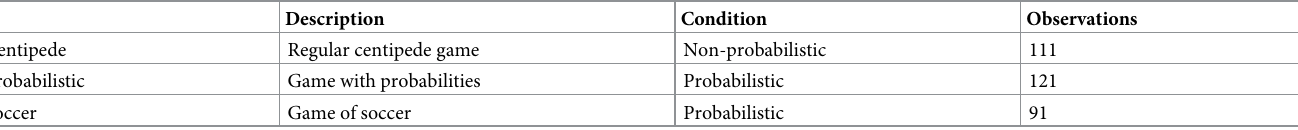
Table 1. Overview of the baseline and the two